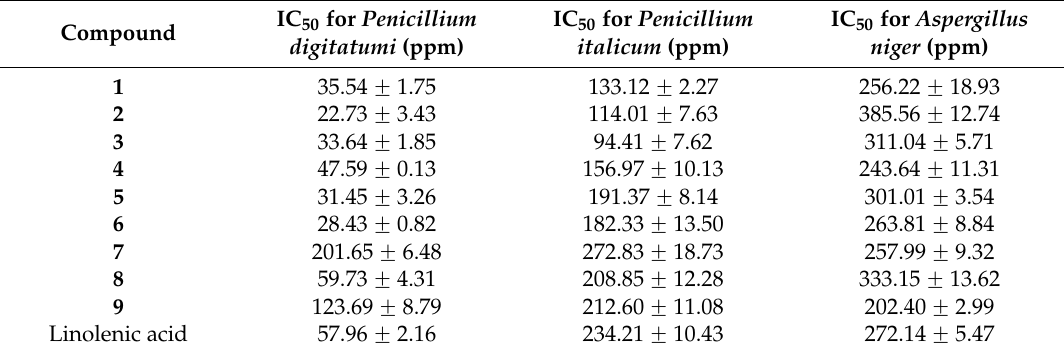
Table 1. IC 50 values of the tested compounds against three citrus postharvest pathogens. Compound